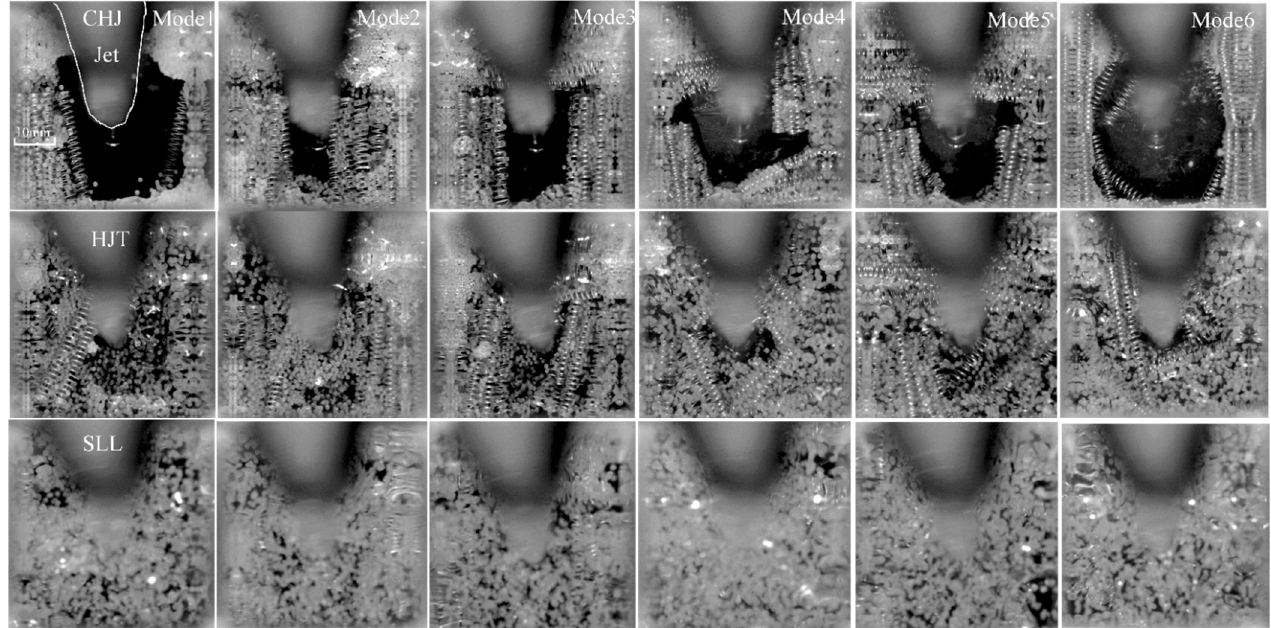
Figure 8. The hydraulic jump form and spring and particles arrangement in three physical forms of the hydraulic jump of the top view (casting speed of 2.4 m/min, modes 1–6).